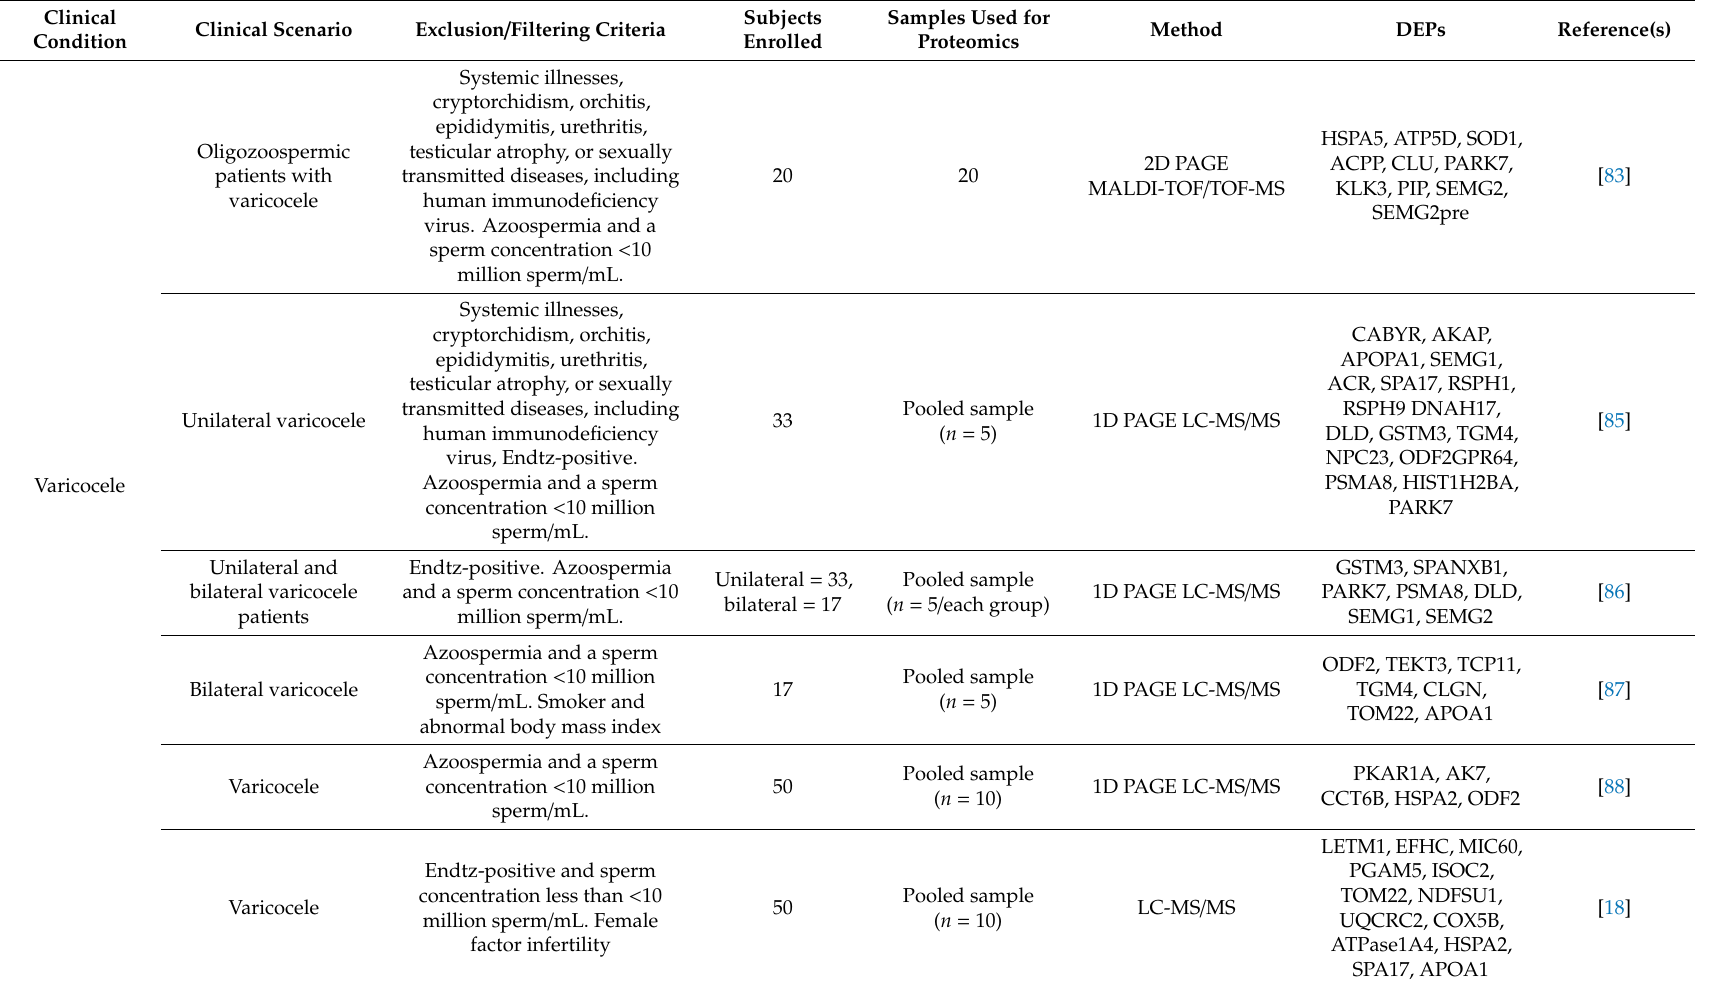
Table 1. Key di ff erentially expressed proteins (DEPs) identified by sperm proteomic profiling in various clinical conditions associated with male infertility. Clinical